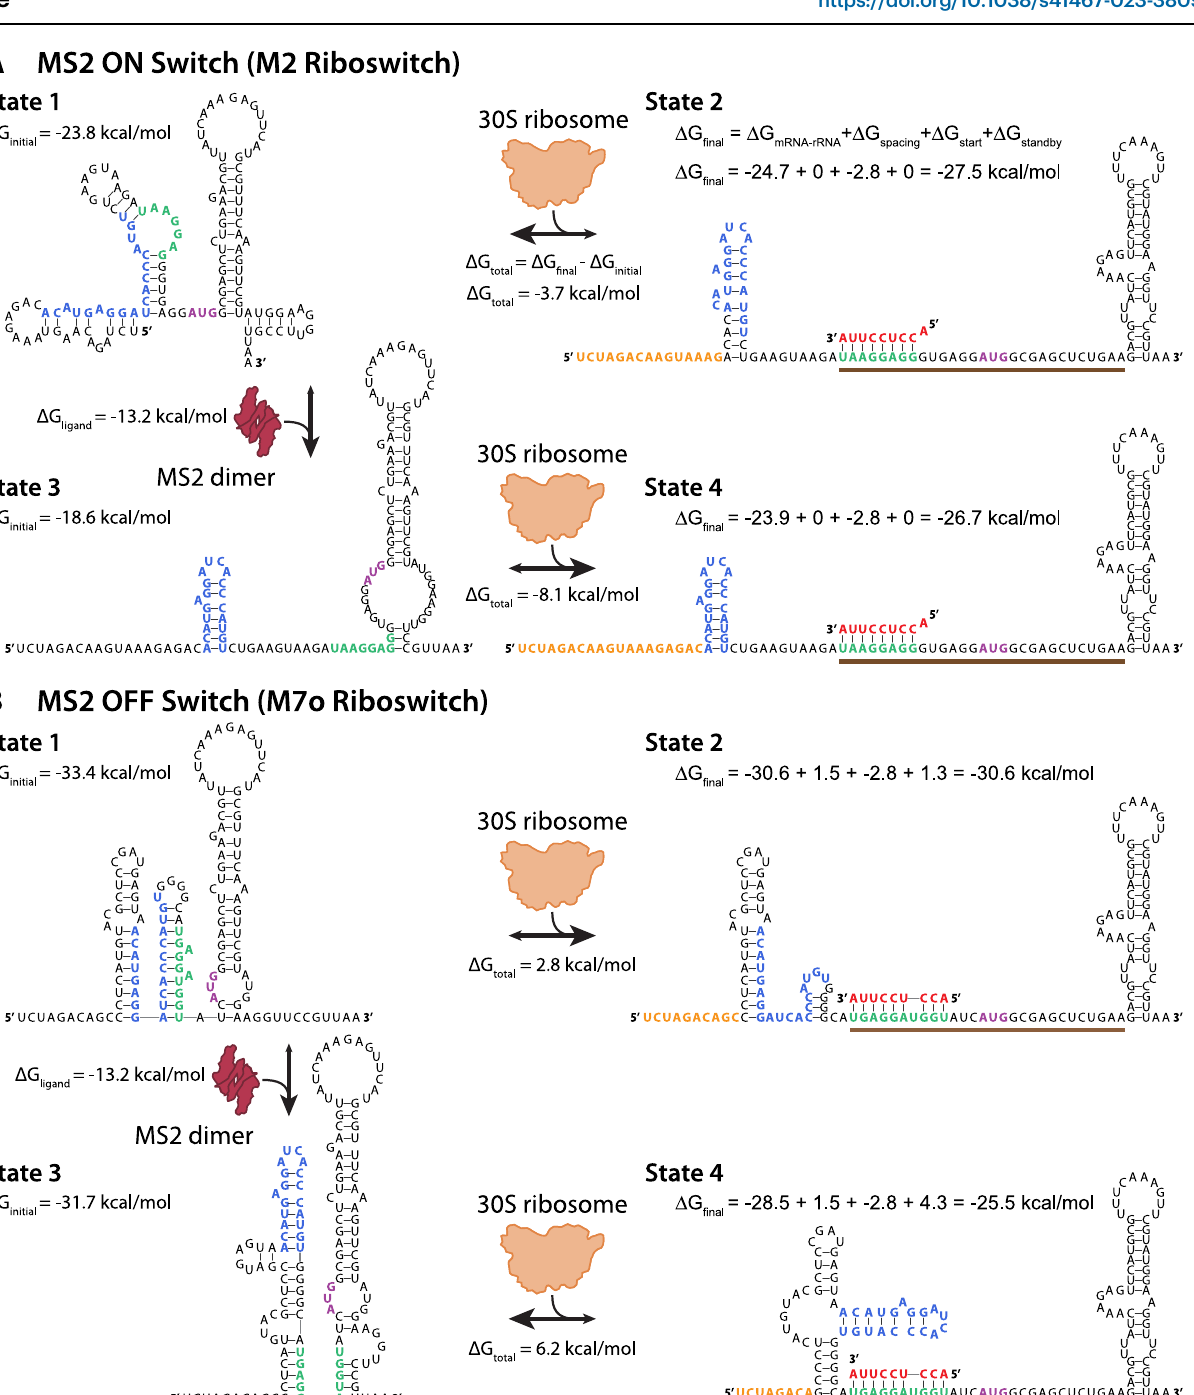
Fig. 3 | Sequence, structure, and interactions controlling riboswitch function. The model-predicted mRNA structures and ribosome-mRNA binding free energies for the A MS2 ON switch (M2 riboswitch) and the B MS2 OFF switch (M7o ribos- witch)acrossitsfourmostrelevantstates. State1 showsthe initialmRNAstructure and its Gibbs free energy of folding ( Δ G initial ) when the MS2 coat protein is not bound.State2showsthechangeinmRNAstructureandthe fi nalGibbsfreeenergy ( Δ G fi nal )whentheribosomebindstothemRNAinState1.Thefreeenergymodelfor calculating Δ G fi nal includes hybridization between the mRNA and ribosomal RNA ( Δ G mRNA-rRNA ), base pairing between the tRNA and start codon ( Δ G start ), and ener- getic penalties fornon-optimal spacing ( Δ G spacing ) and aninaccessible standby site